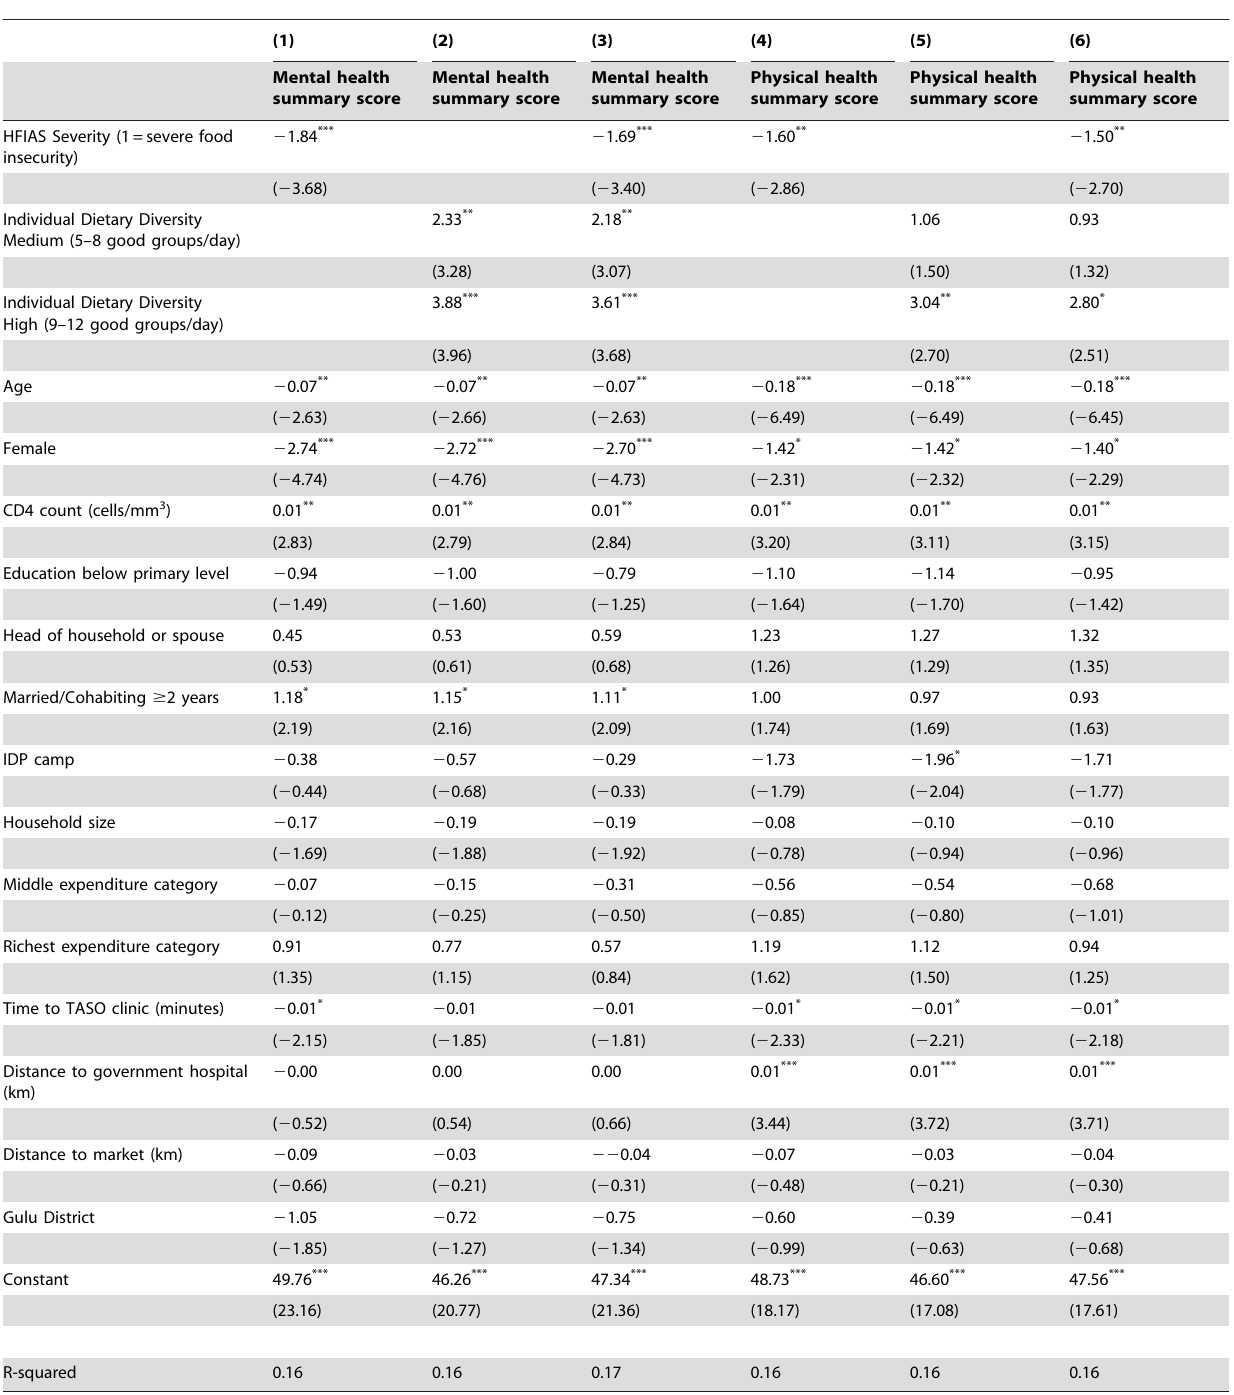
Table 3. Multivariate regression models of association between HFIAS, IDDS and Mental & Physical Health Summary Score